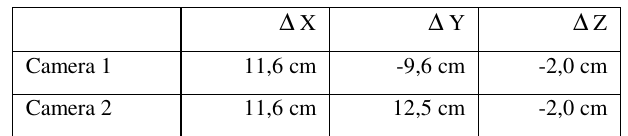
Table 2: Metric excentricity in camera centers measured at the sensor